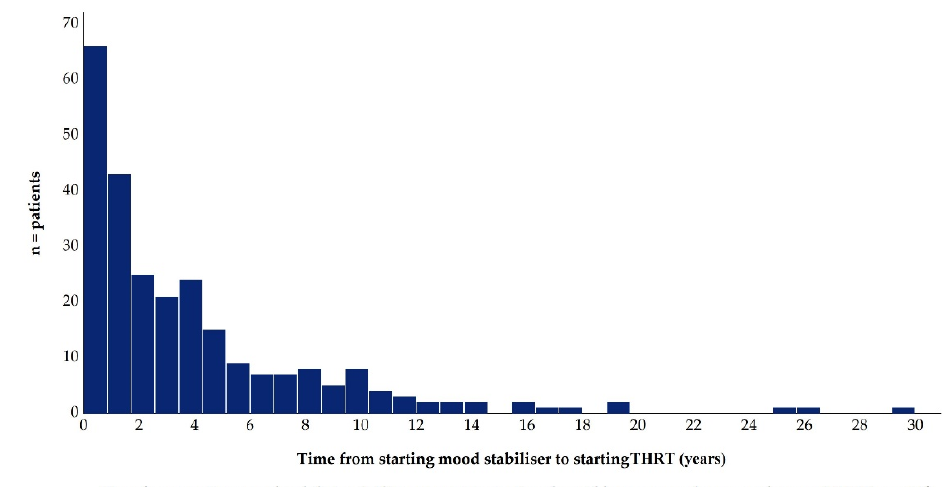
Figure 7. Time from starting MS to Thyroid Hormone Replacement